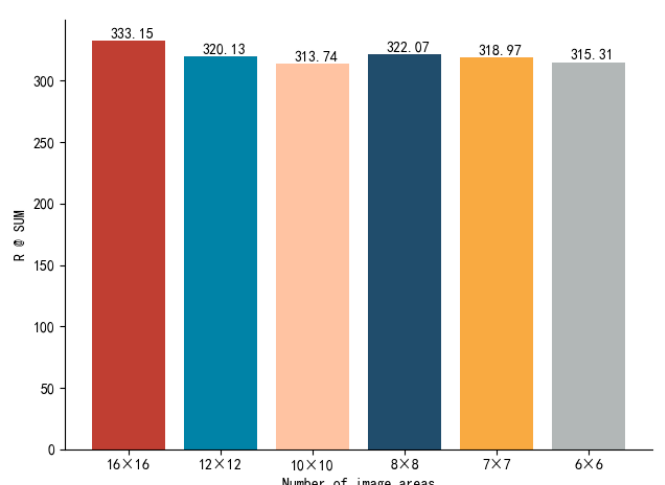
Figure 10. Variations of model precision over the Sydney-Captions dataset with the number of im- age